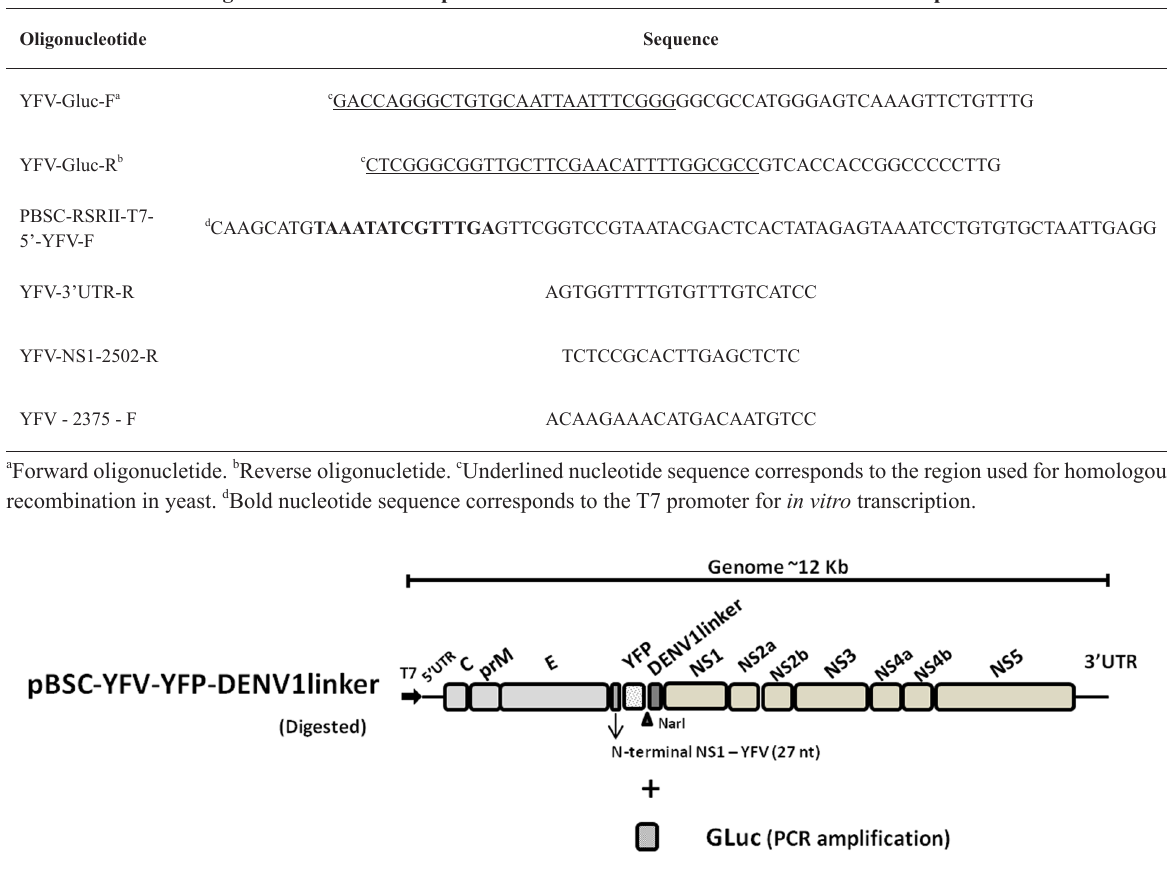
and a final extension at 72°C for 20 min. The full- length PCR product, which has the bacteriophage T7 promoter in the 5’ terminal sequence, was purified by phenol-chloroform extraction followed by ethanol precipitation, and transcribed using